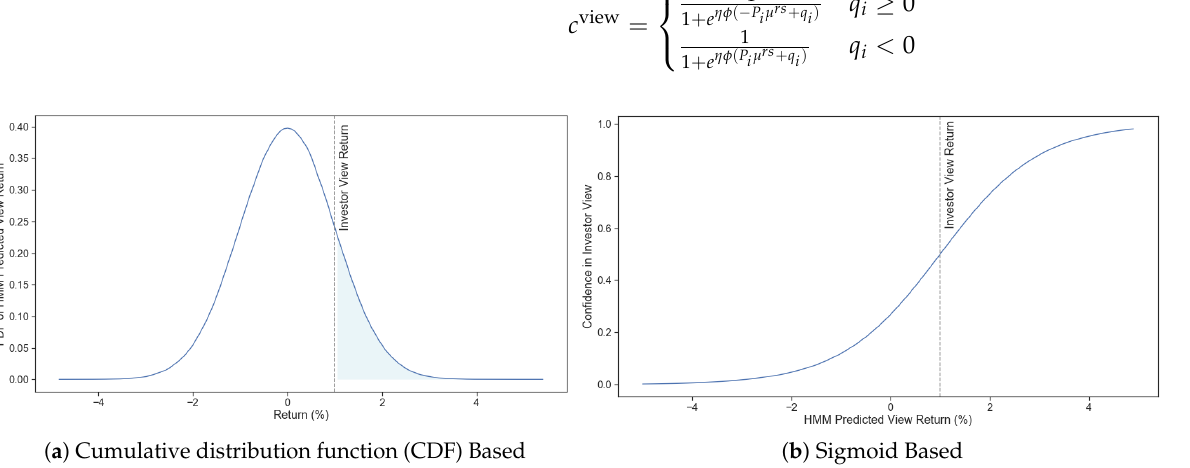
Figure 4. Quantitative Confidence Methods for Investor